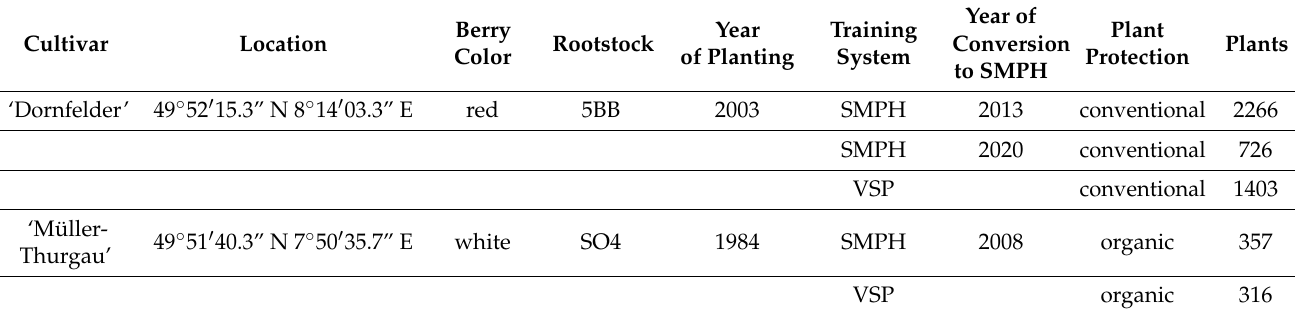
Table 1. Properties of studied